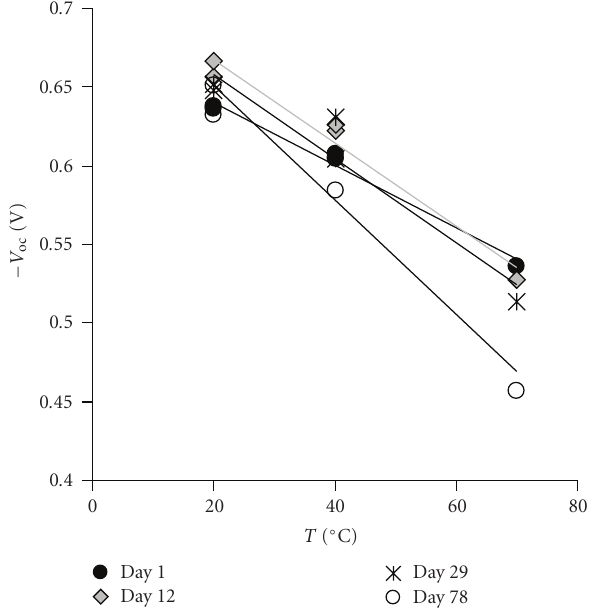
Figure 5: Temperature dependence of the open circuit voltage: first set of EIS